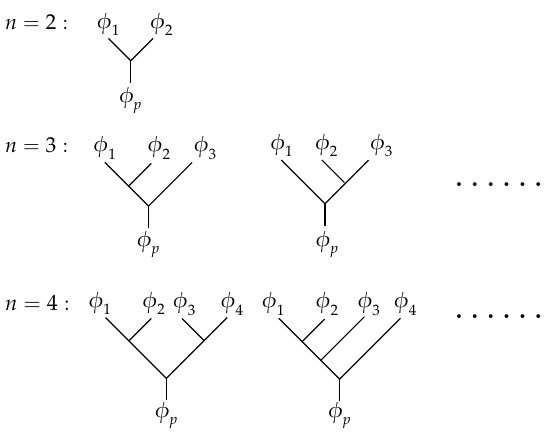
Figure 4 . Given a particular OPE channel, (cid:30) p is the last operator appearing in the